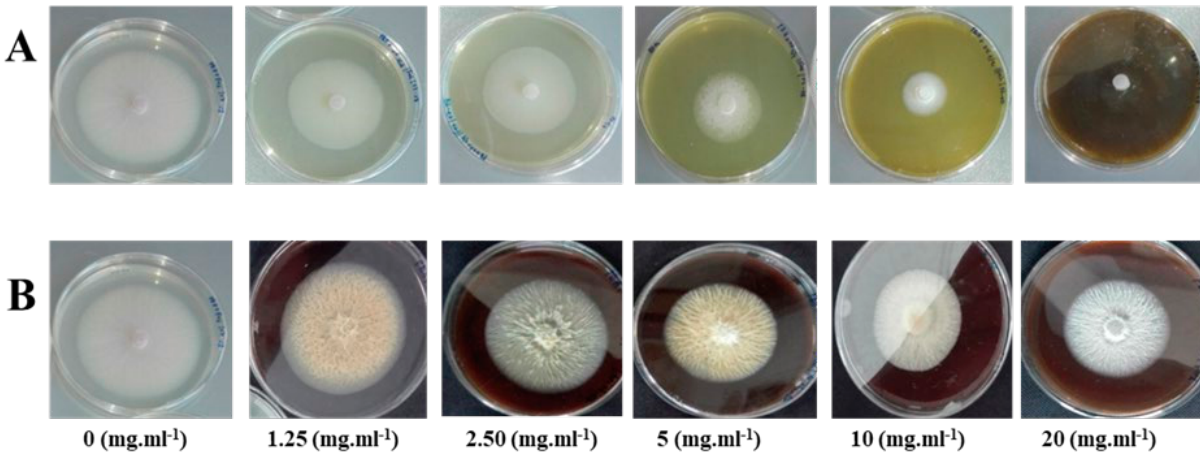
Figure 2. Inhibition of mycelium growth of Fusarium oxysporum f. sp. vasinfectum after 7 d on PDA supplemented with increasing concen- trations of ethanol extract (A) and water extract (B) from Euphorbia hirta